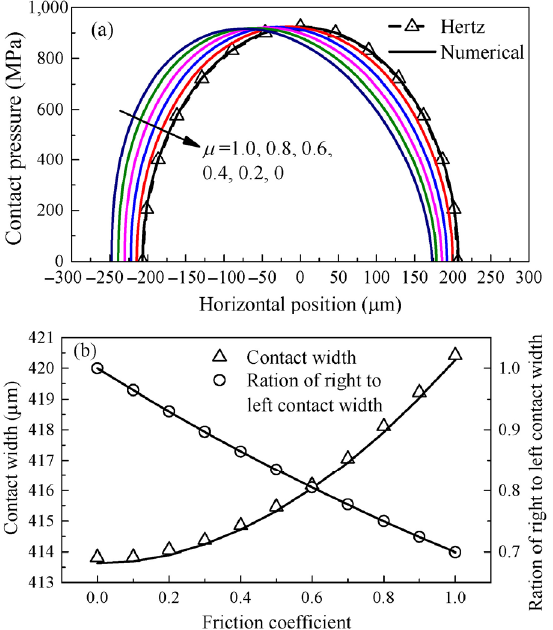
Fig. 4 Comparison of Hertzian problem from analytical solution and numerical results under different friction coefficients: (a) distribution of contact pressure; (b) numerical (symbol) and theoretical (line) results of contact width and ratio of right to left contact width. Other parameters, object 1: object 2: rigid body. 300 kN / m  L , 24.61mm  R